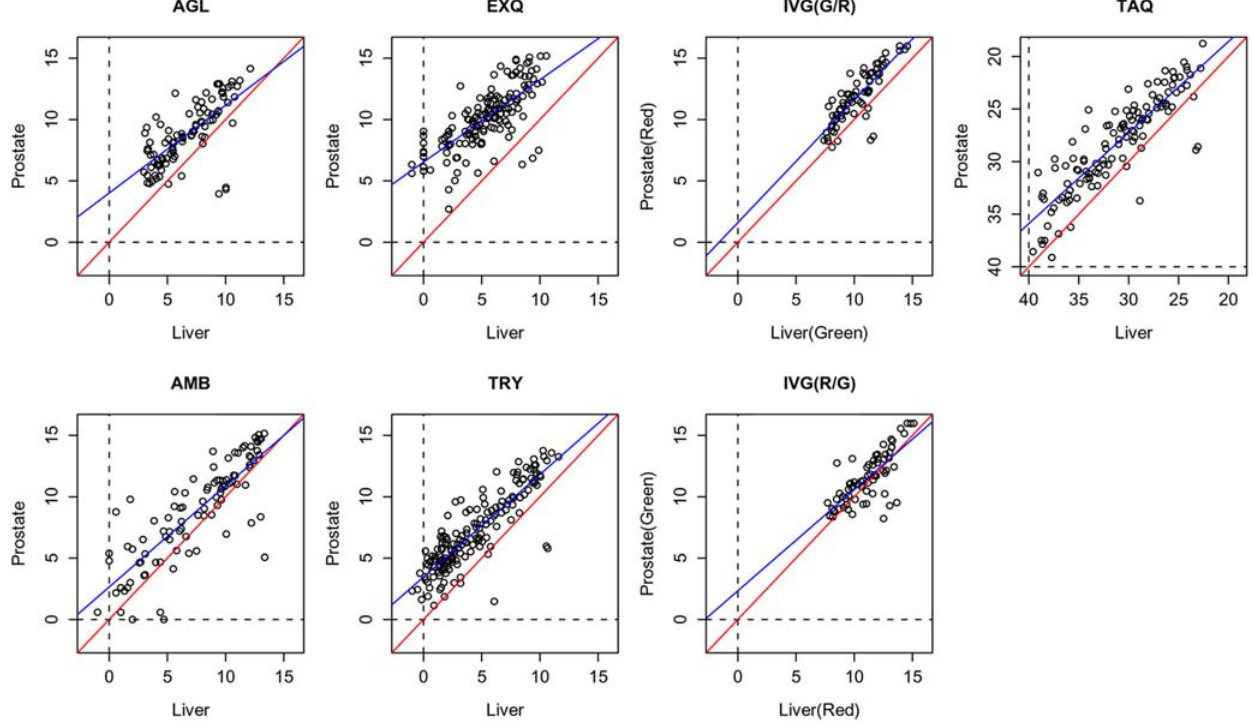
Figure 1. MicroRNA expression level in human liver and prostate tissues. For the microarray platforms, log2 transformed values of representative signal intensity for detection call-positive microRNAs were plotted. For the Taqman analysis, Ct values of microRNAs were plotted. Red and blue lines indicate Y=X line and regressed linear line, respectively. In all scatter plots. blue lines were shifted upward, which indicated that the general microRNA expression level in human prostate was higher than in human